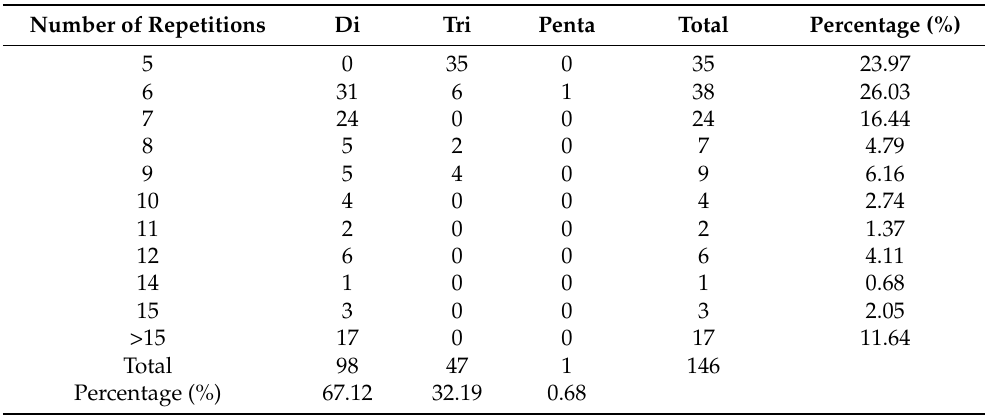
Table 3. The relationship between the frequency of different SSR repeat motif types and the number of repeat motifs in the CpTPSs